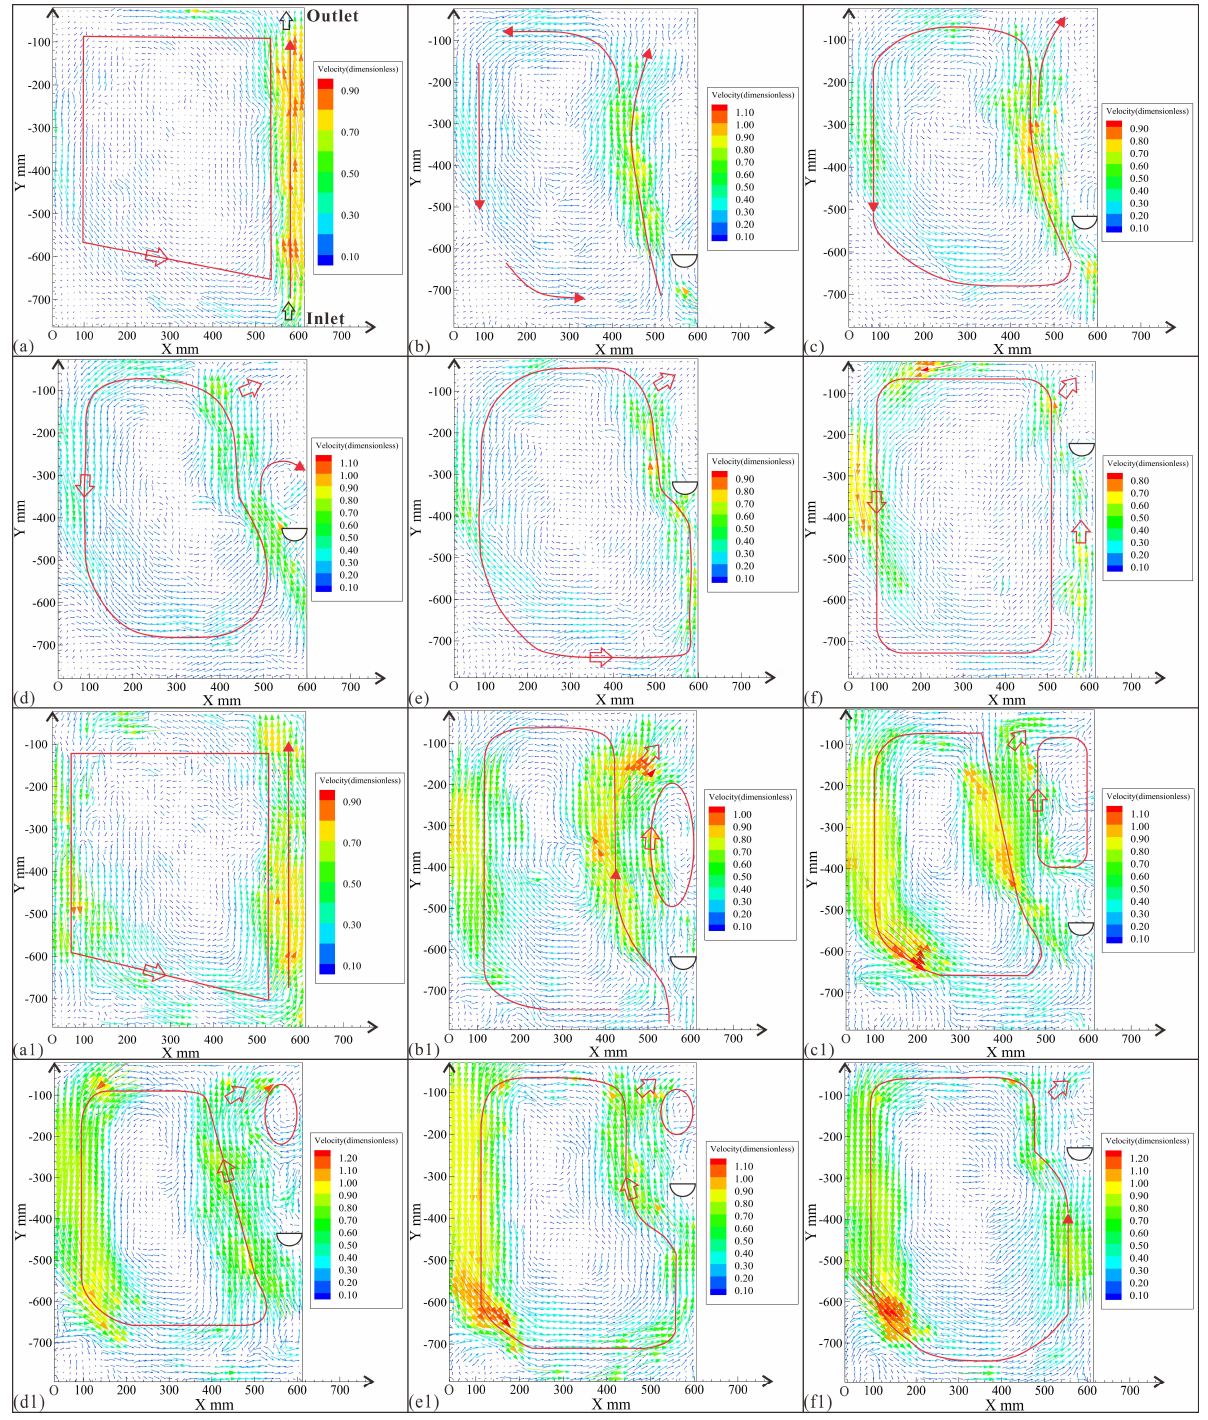
Figure 6. Vector distribution of the flow field under the influence of the semi-cylinder for Q = 3.7 L/min and 6.8 L/min, respectively: ( a – f ) for 3.7 L/min; ( a1 – f1 ) for 6.8 L/min. Vector distribution ( a , a1 ) for no structure; ( b , b1 ) for l = 0.19; ( c , c1 ) for l = 0.31; ( d , d1 ) for l = 0.44; ( e , e1 ) for l = 0.56; ( f , f1 ) for l = 0.69.